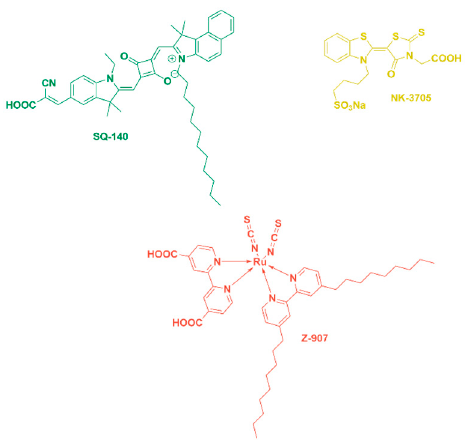
Figure 9. Chemical structures of visible and NIR dyes utilized for the fabrication of BF-DSSCs.